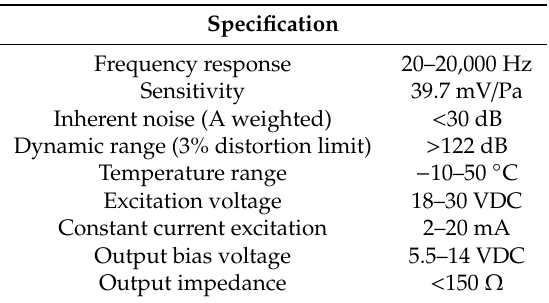
Table 1. Pipe microphone